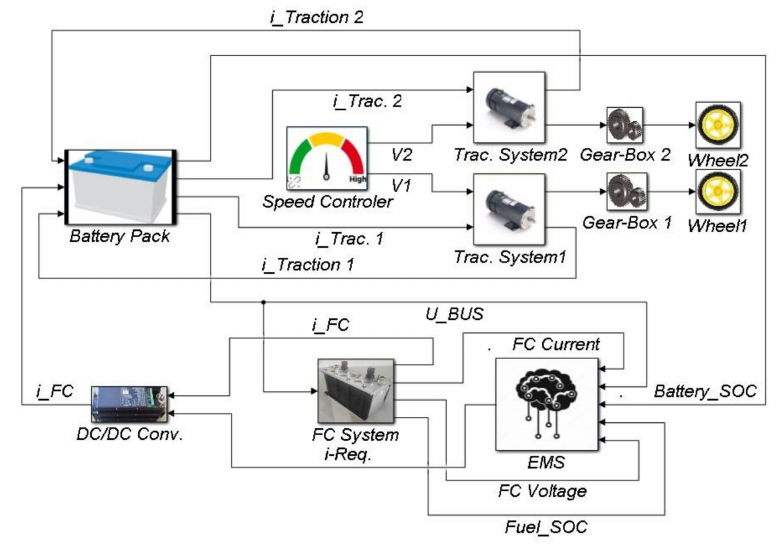
Figure 4. The overall Matlab Simulink model of the